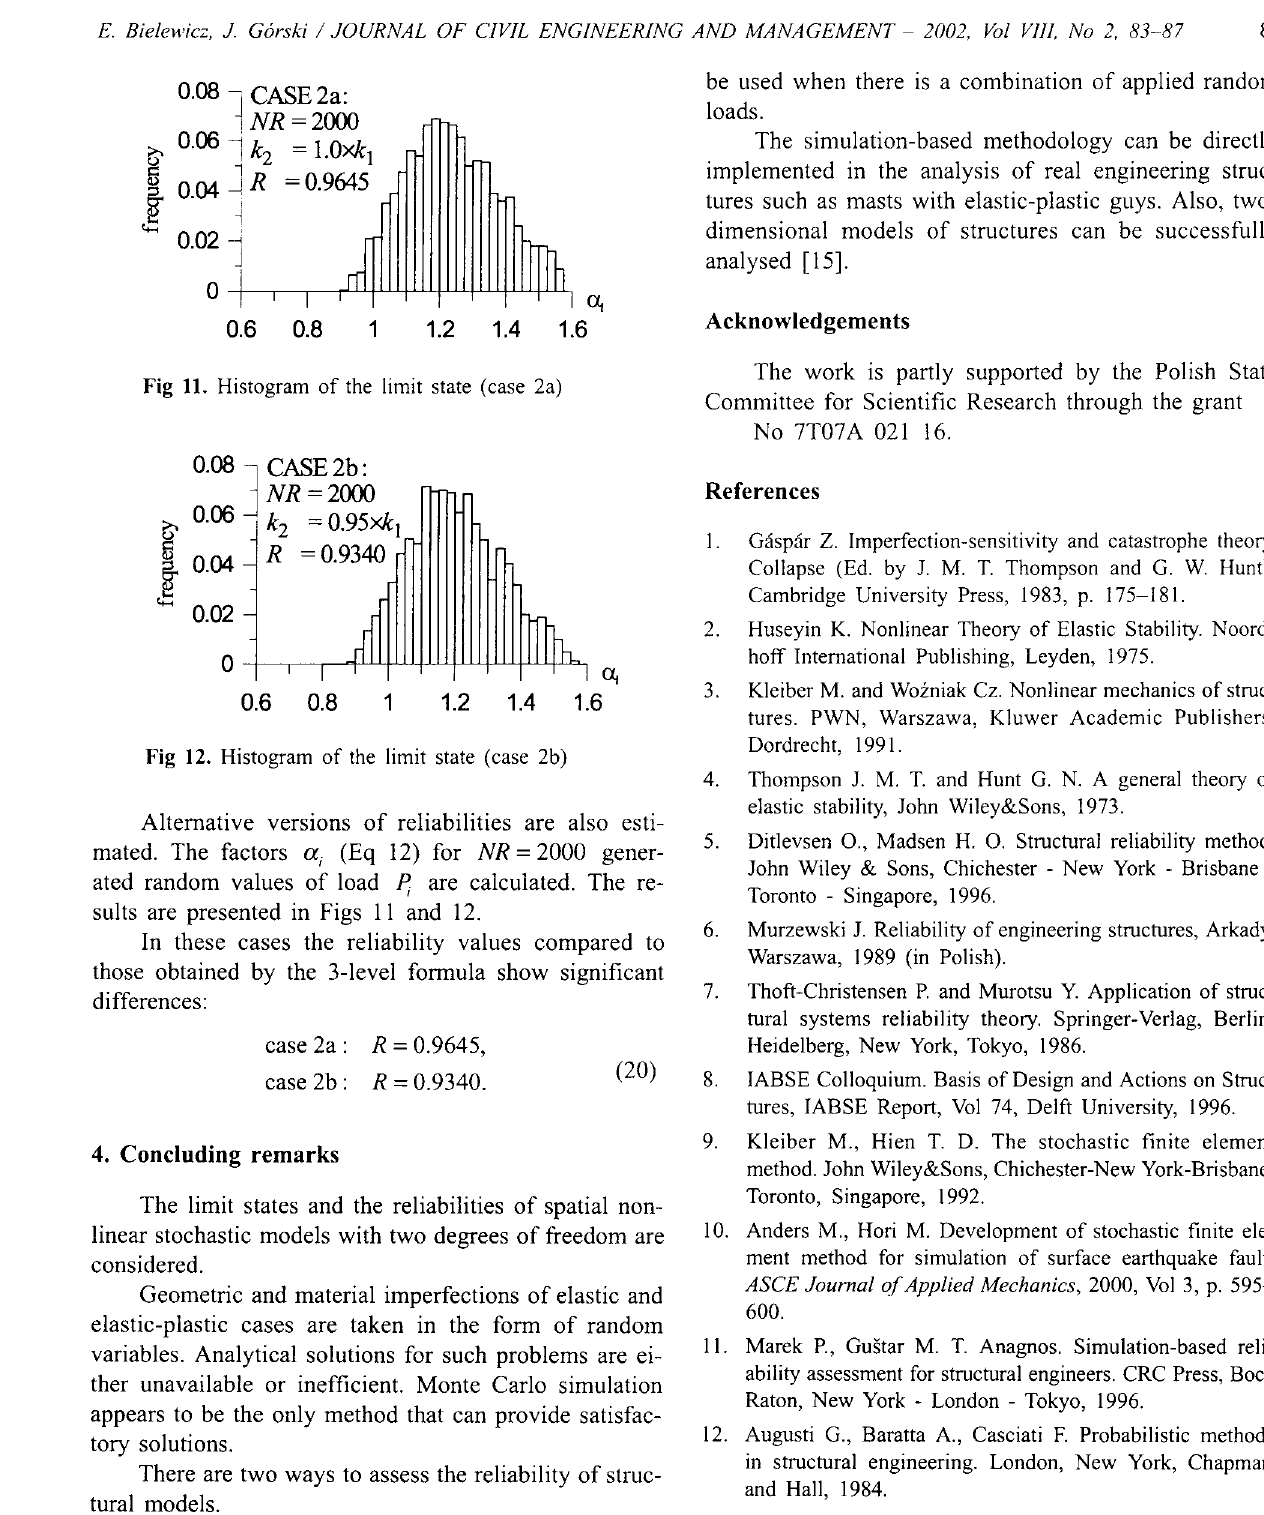
Fig 11. Histogram of the limit state (case 2a)